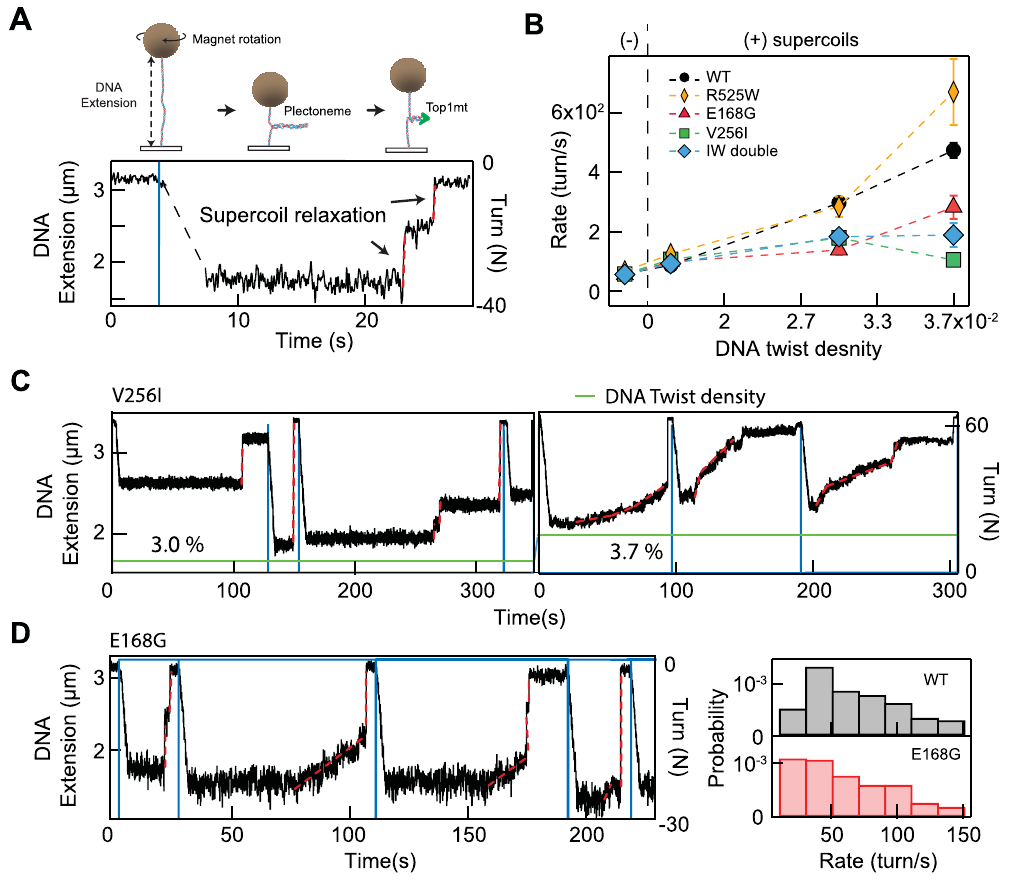
Figure 4. Single-molecule assay to characterize DNA supercoil relaxation activity of WT TOP1MT and three TOP1MT variants. ( A ) Schematic of single-molecule DNA supercoil generation and measurement of TOP1 relaxation using magnetic tweezers (not to scale). The DNA extension decreases as supercoils are introduced in the DNA molecule by rotating DNA tethered magnetic bead with the external magnets (see methods). The DNA extension increases as TOP1 relaxes the supercoiled DNA molecule. Individual TOP1 supercoil relaxation events (highlighted with dashed red lines) are analyzed to extract the rate of supercoil relaxation and the number of supercoils relaxed per cleavage-religation cycle. ( B ) The supercoil relaxation rate for WT and three TOP1MT variants as a function of the imposed twist on the DNA, proportional to the torque applied on the DNA. ( C ) Single-molecule relaxation measurements illustrating decreased relaxation activity of V256I TOP1MT variant under high positive DNA twist density (3.7%). The DNA extension is plotted as a function of time (black line, left axis), the introduction of supercoils is indicated by the blue lines (right axis), the twist density is reported as a percentage and indicated by the green line. Note the variation in relaxation rate during individual relaxation events (e.g., at ~100 s on the right panel) and the increased prevalence of slow relaxation events at higher (3.7%) twist density (right panel) compared to the lower (3.0%) twist density (left panel) ( D ) Example of random switching between slow and WT relaxation rates for E168G TOP1MT (left panel). The distributions of relaxation rates indicate a higher probability of slow relaxation rate events ( < 20 turn/s; marked as shade) for the E168G variant compared to WT Top1mt (right